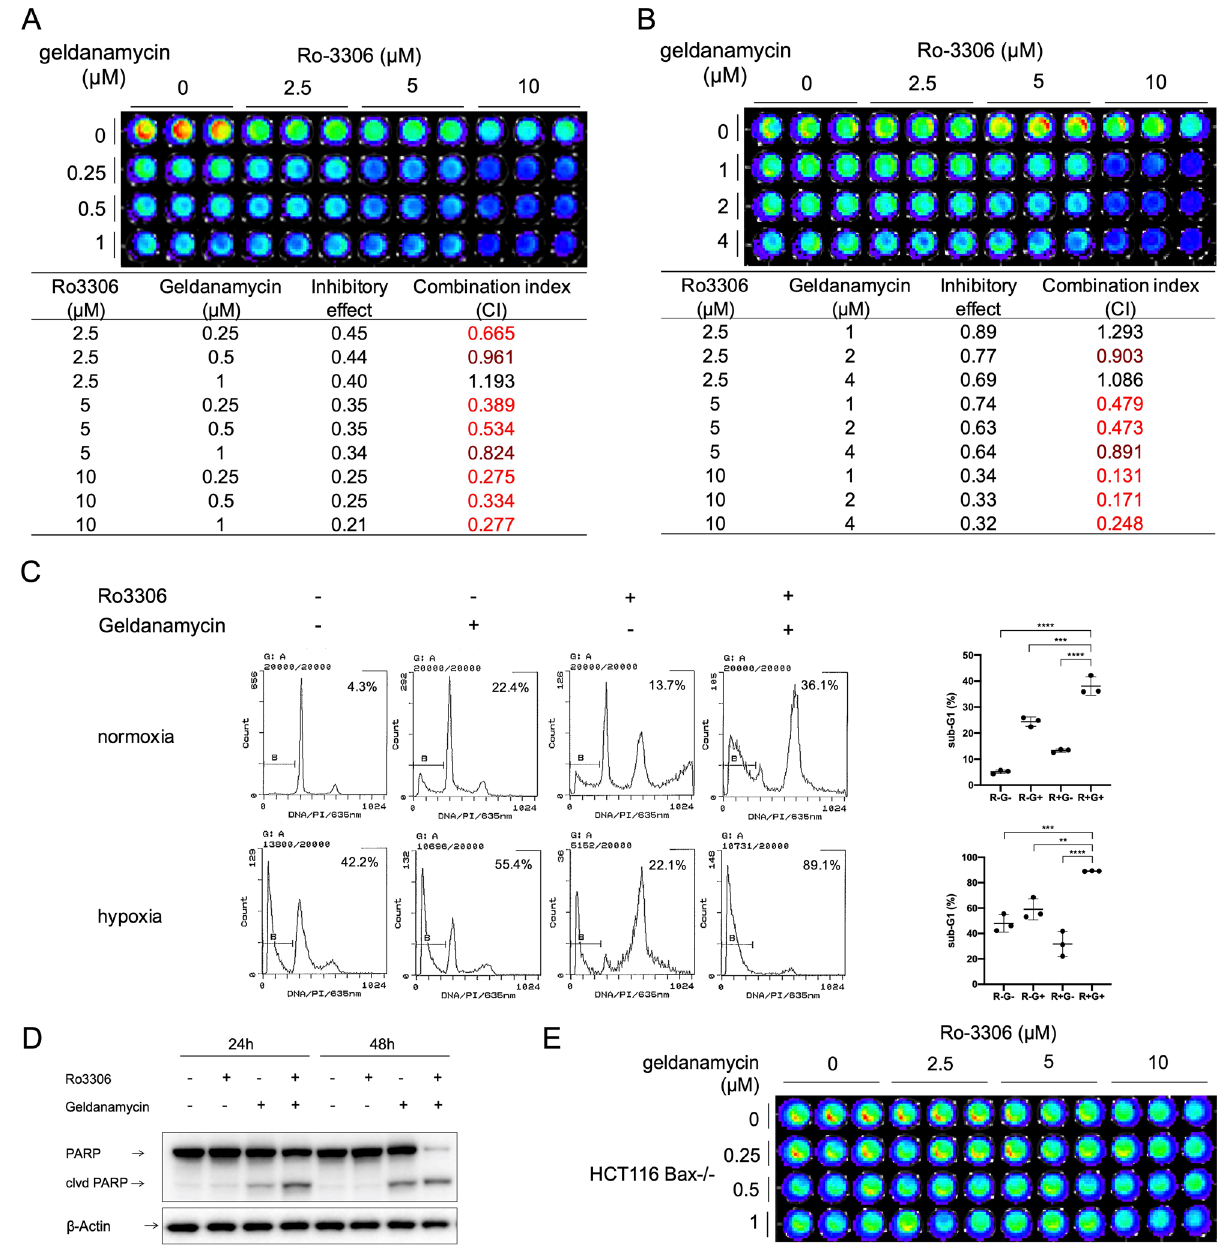
Figure 3. Ro-3306 and geldanamycin synergistically inhibit HCT116 cell viability through induction of apoptosis. ( A ) In normoxia or ( B ) hypoxia (0.5% O 2 ), cells were treated with Ro-3306 and geldanamycin at the indicated concentrations for ( A ) 48 or ( B ) 72 h. ( C ) Sub-G1 analysis by propidium iodide staining and flow cytometry of cells treated with Ro-3306 (10 μM) and geldanamycin (1 μM) under normoxia for 48 h or under hypoxia for 72 h. ( D ) Western blot of PARP cleavage in cells treated with Ro-3306 or geldanamycin or both. ( Ε ) CellTiter-Glo analysis of cell viability in HCT116 Bax -/- cells treated at indicated concentrations under normoxia for 48 h. Statistical analysis was performed using one-way ANOVA supplemented with Dunnett test. Mean ± SD was shown. * p < 0.05, ** p < 0.01, *** p < 0.001, **** p <